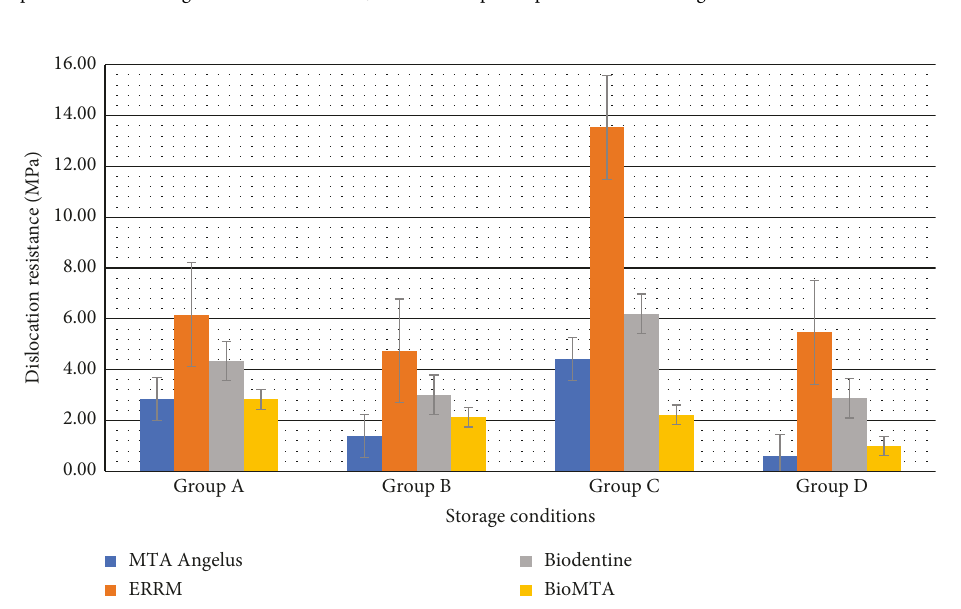
Figure 6: Mean values for dislocation resistance between tested CSC materials. ERRM had the highest values (13,54 ± 5,56MPa) after exposure to pH 7.2 (group C).